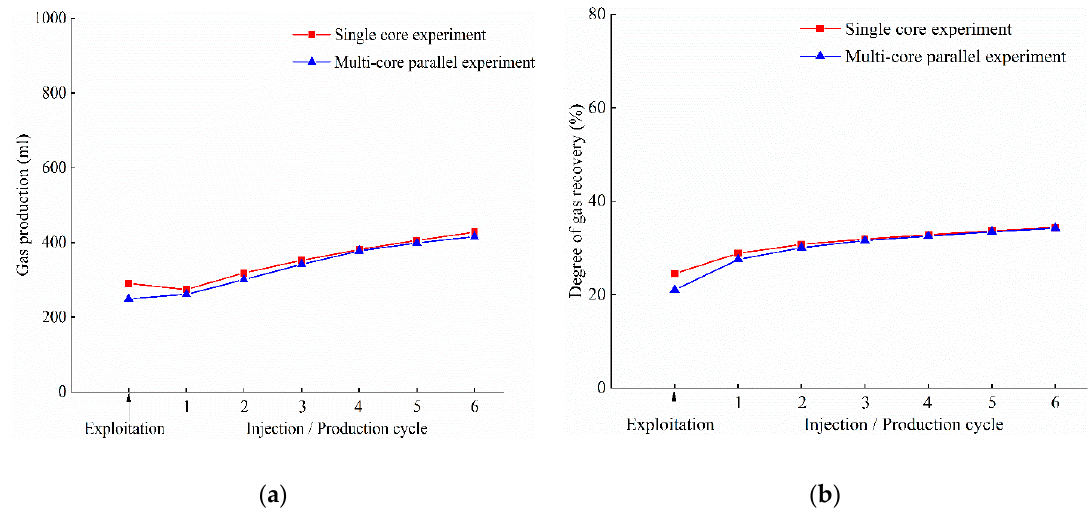
Figure 11. Variation curve of gas production ( a ) and degree of gas recovery ( b ) with reservoir heterogeneous in the gas-drive-water gas zone.